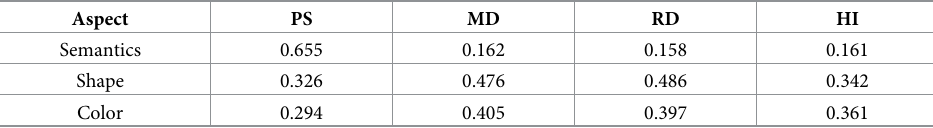
Table 3. MAP of top 10 similar pictures from different user perspectives in Nipic.